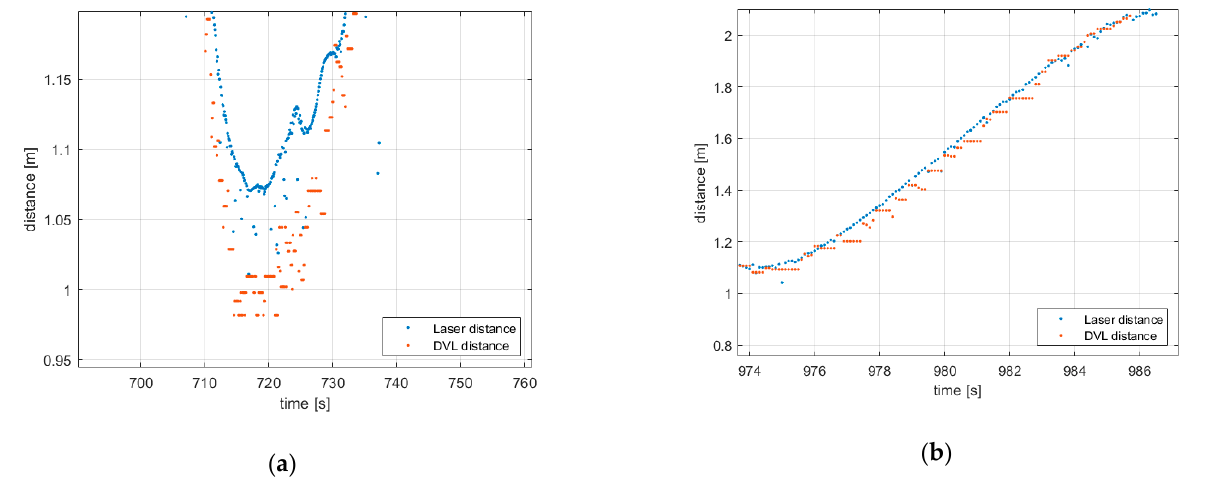
Figure 17. Zoomed in distance measurements from the laser triangulation sensor and the DVL which show quantization effects.